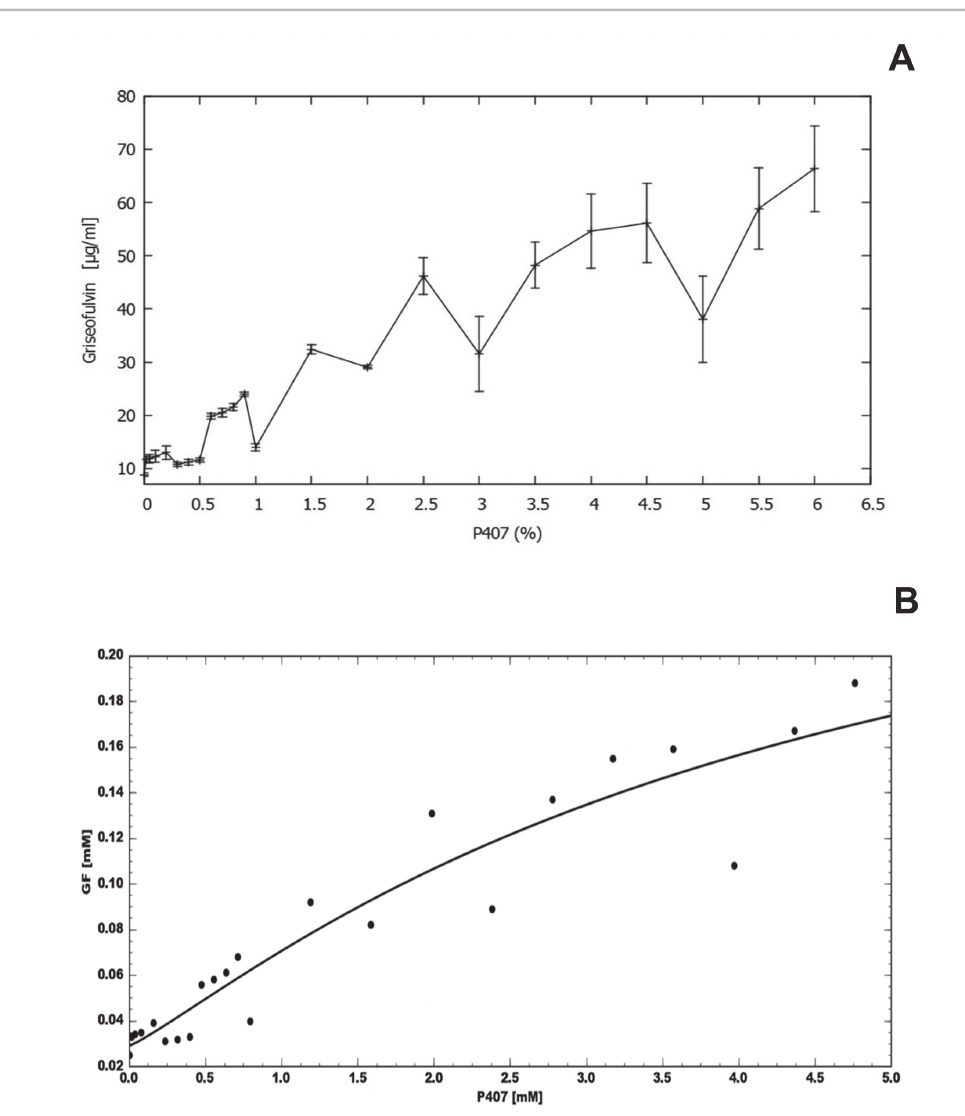
Figure 2 - Curve of GF solubilized (µg/mL) versus P407 concentration (%) (A); and the curve of GF solubilized (mM) versus P407 concentration (mM) adjusted by the Morgan-Mercer-Flodin model (CurveExpertPro-2.6.3)